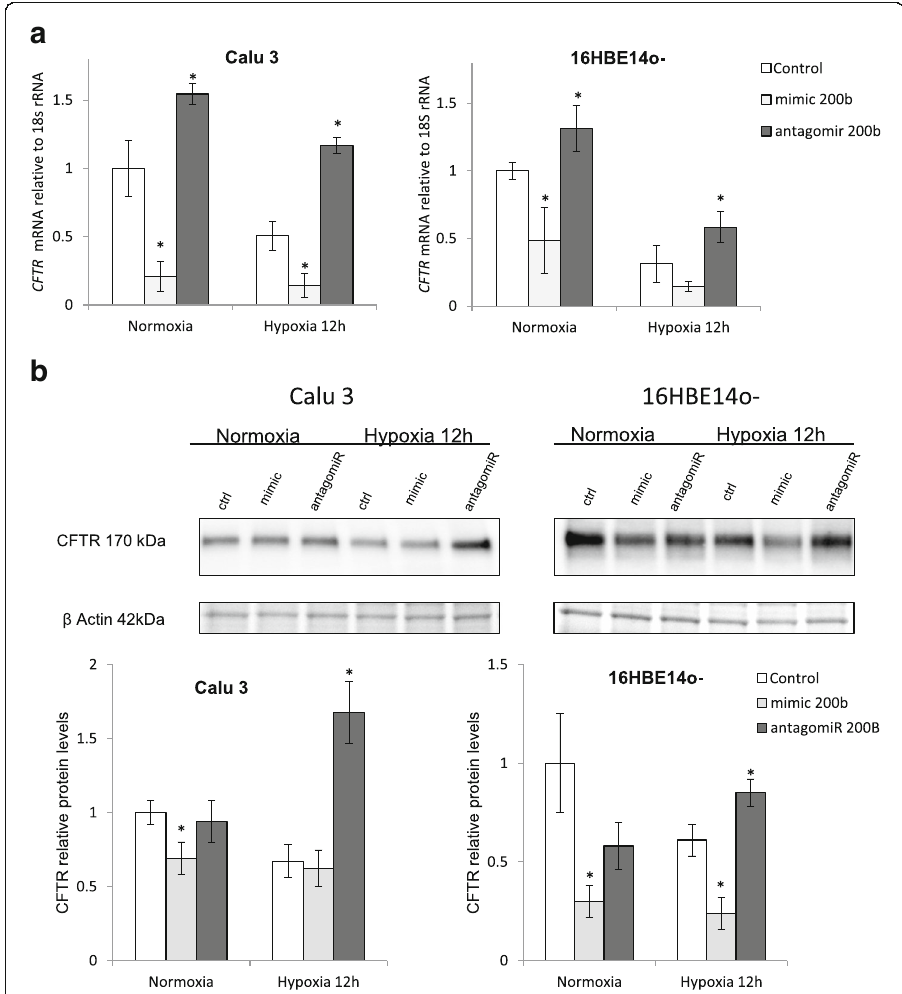
Fig. 5 miR-200b decreases the expression of CFTR mRNA during normoxia and hypoxia. a Calu3 and 16HBE14o- cells were transfected with miR-200b mimic or antagomir and the mRNA levels were monitored in qRT-PCR experiments in normoxic conditions and after 12 h of hypoxia. CFTR mRNA levels from 2 independent experiments ( n = 8) are normalized to 18S rRNA levels and expressed as a fold change over the transfection control. b The corresponding changes in CFTR protein levels of were detected with SDS-PAGE and Western Blot analyses and normalized to the β -actin levels. Two individual samples (3 μ g of total protein per lane) were tested for each treatment and the experiments were repeated twice. Error bars represent standard deviations (SD). Sig- nificant changes ( P <0.05) are marked with an